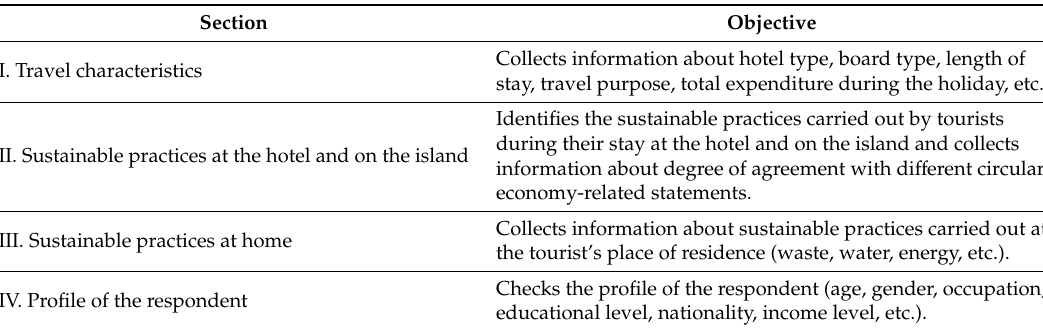
Table 1. Structure of the